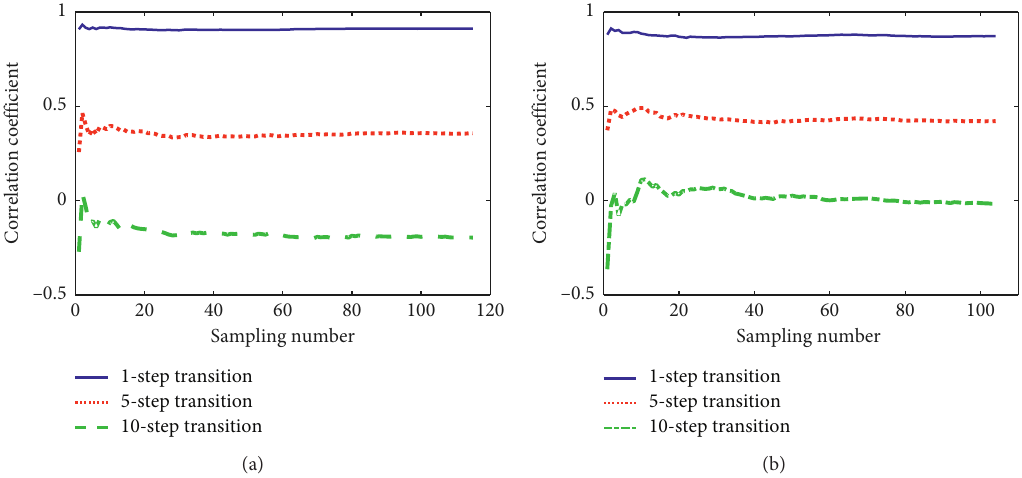
Figure 14: Correlation coefficient analysis with the increase of sampling number. (a) Off-peak hours. (b) Peak